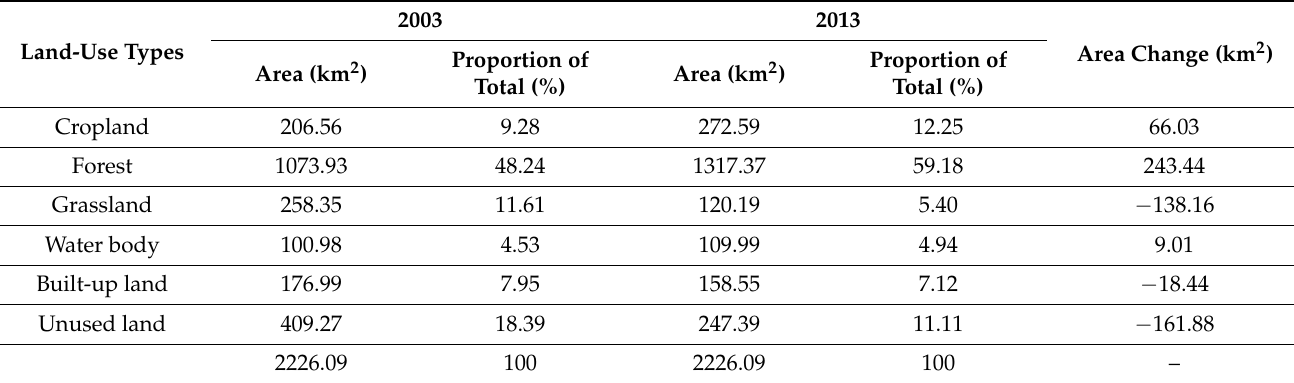
Figure 3. Land use and land cover of the study region in 2003 and 2013. Table 4. Land-use changes from 2003 to 2013 in the study region.